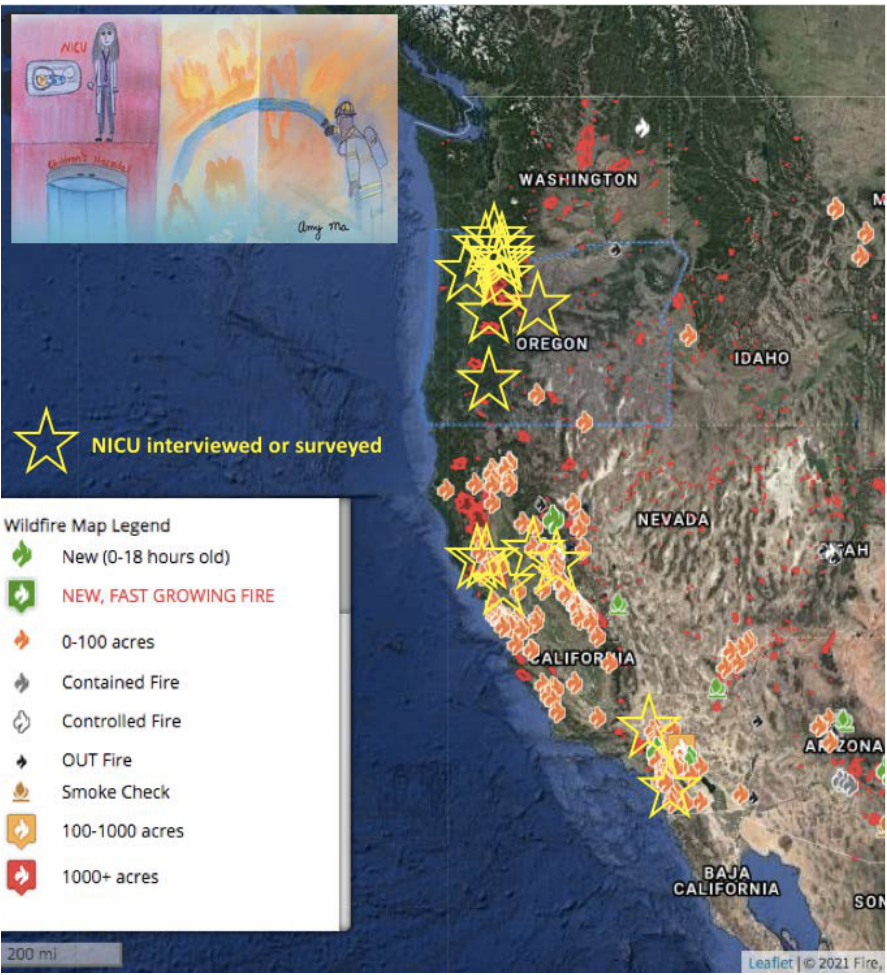
Figure 1. NICUs surveyed or interviewed in California, Oregon, and SW Washington. Fire map accessed in February 2021